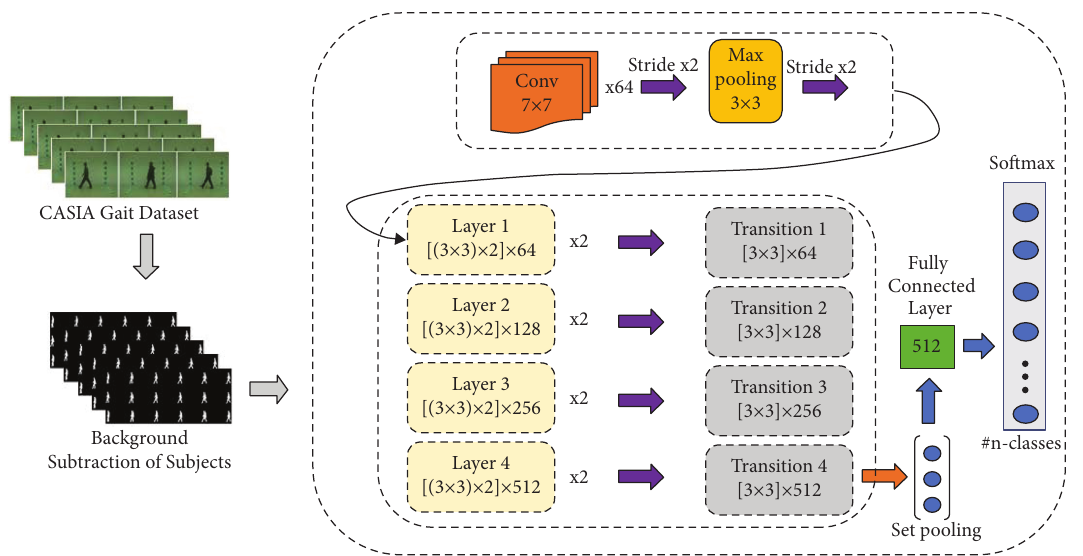
Figure 4: Pictorial representation of the proposed network from architecture Table 1 for image classification.